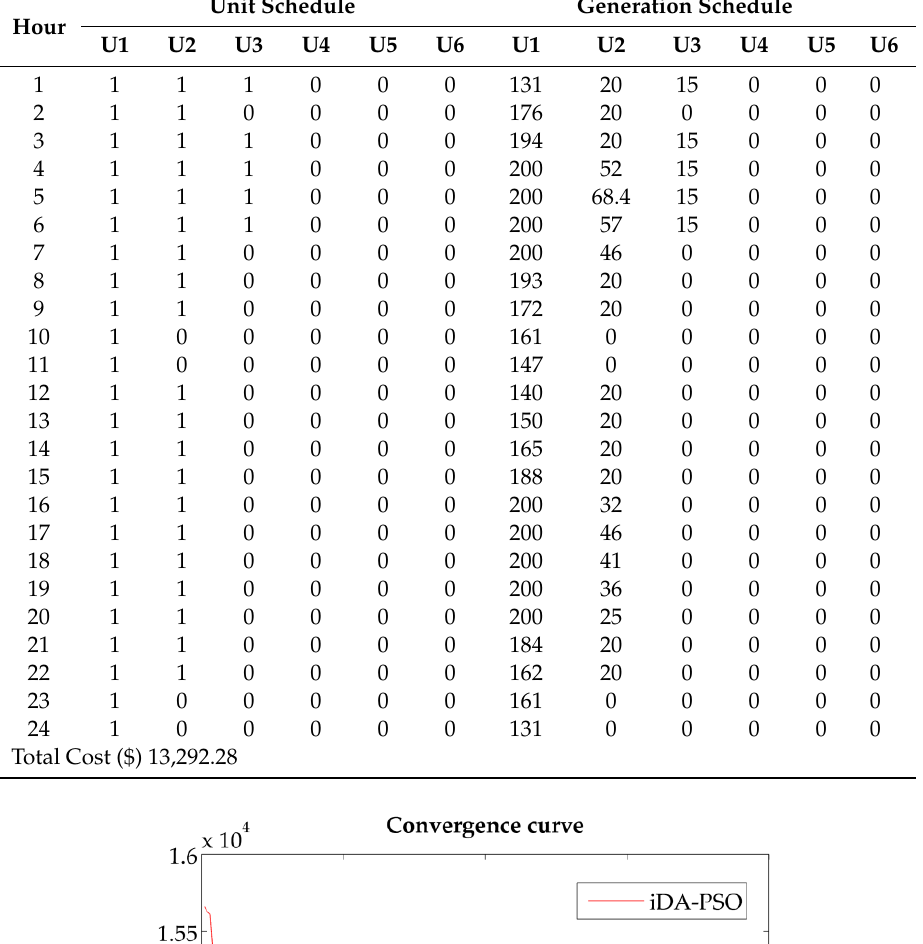
Table 10. Commitment and generation schedule of the 6-unit system by iDA-PSO.